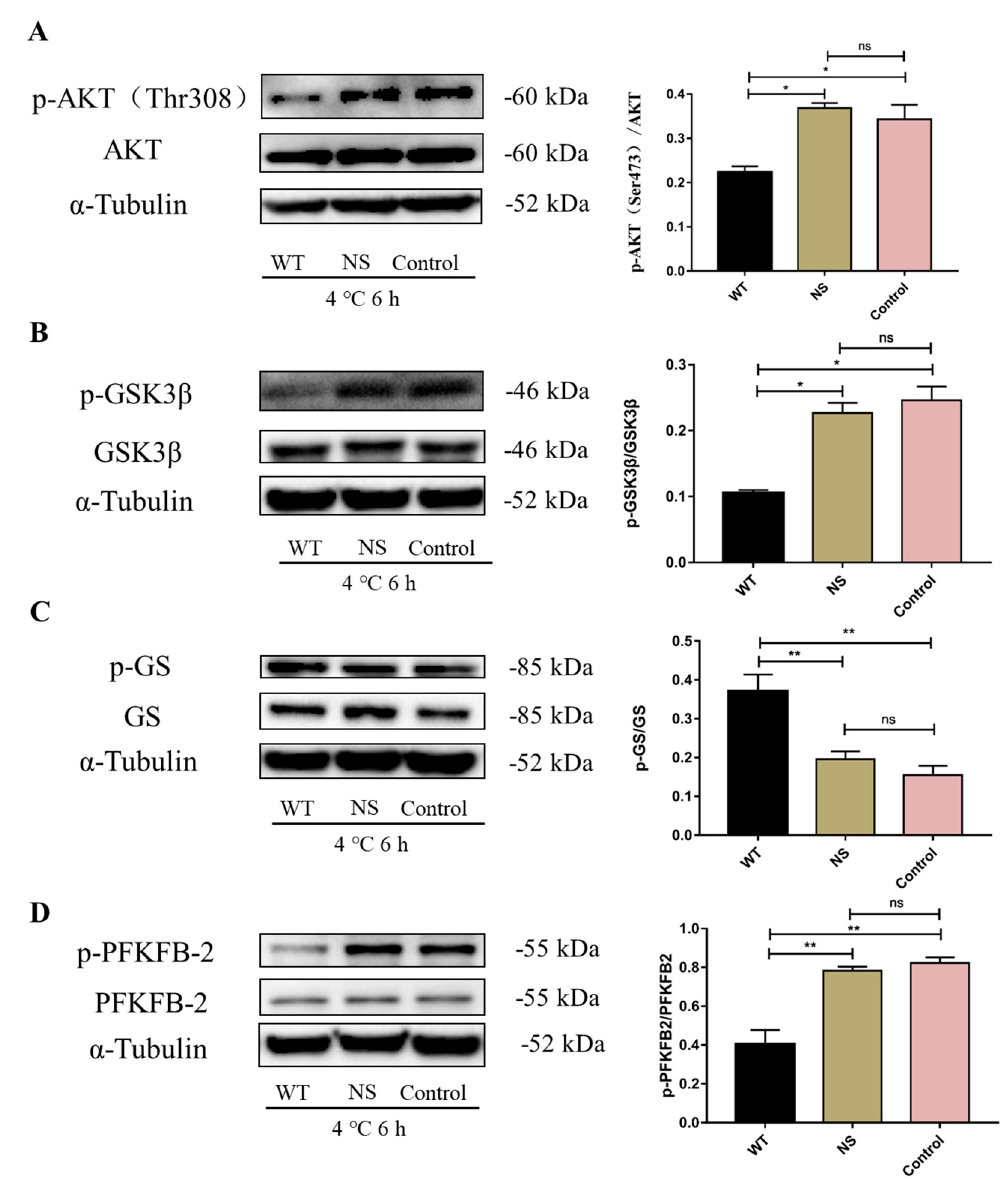
Figure 8. Effect of AKT on glucose metabolism in C57BL/6 mouse livers under cold exposure. ( A ) The level of protein kinase B (AKT) protein and phosphorylation status (Thr308) in the liver; ( B ) the level of glycogen synthase kinase-3 β (GSK3 β ) protein and phosphorylation status (Ser9) in the liver; ( C ) the level of glycogen synthase (GS) protein and phosphorylation status (Ser641) in the liver; ( D ) the level of 6-phosphofructo-2-kinase/fructose-2,6-biphosphatase 2 (PFKFB2) protein and phosphorylation status (Ser483) in the liver. The data are presented as the mean ± SEM ( n = 8). Statistically significant differences are indicated; * p < 0.05 and ** p < 0.01.